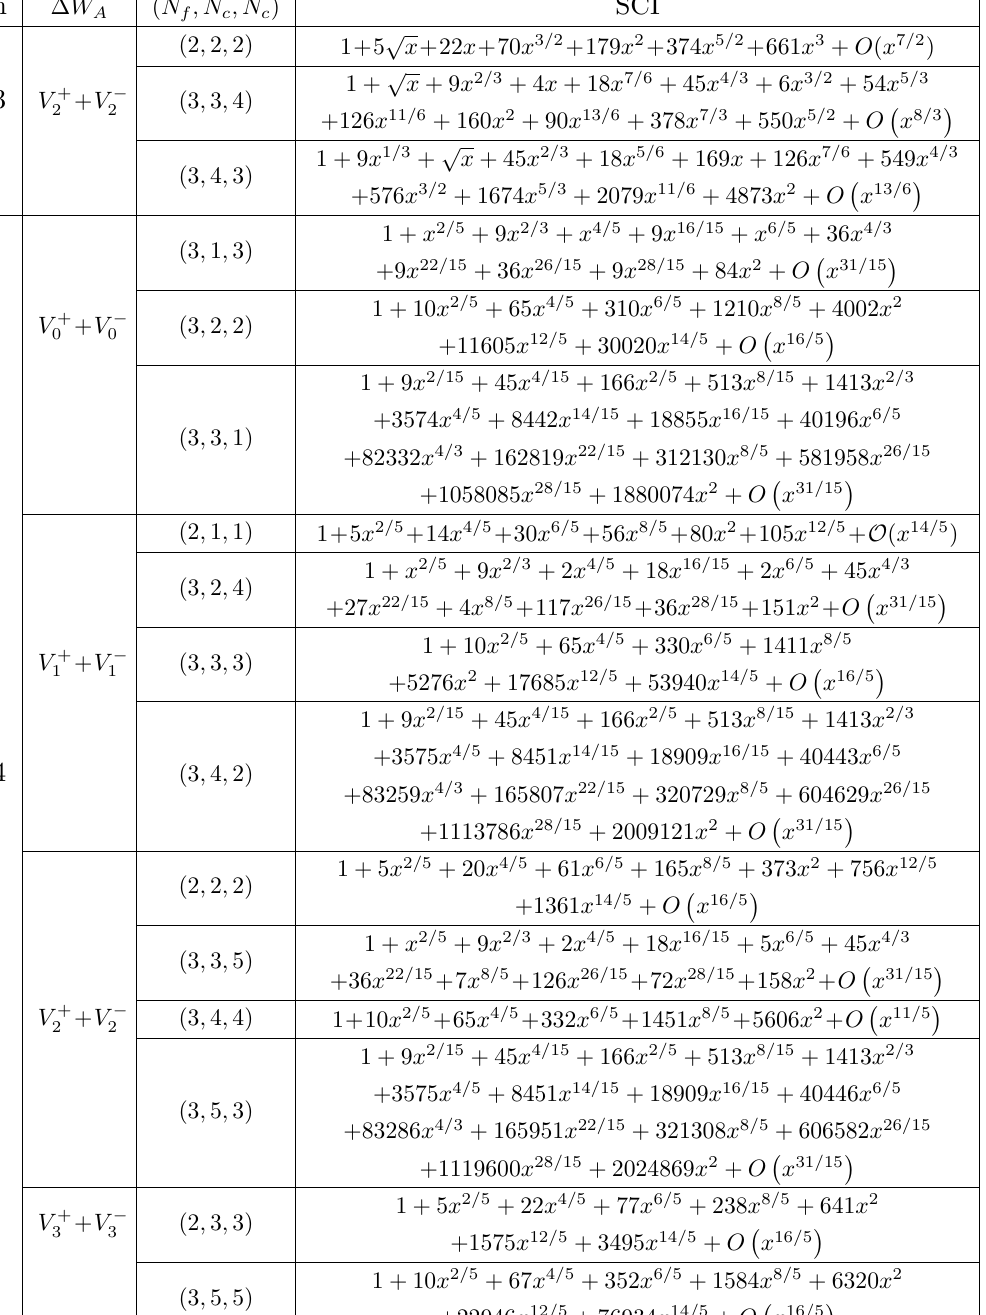
Table 13 . The superconformal index results for the single adjoint theories with ∆ W A = V + For simplicity, the SU( N ) SU( N ) flavor fugacities are all omitted. This table includes all f t × f u ˜ possible cases up to n ≤ 4 , N 3 , and N N c ≤ 5 with conditions ∆ Q , ∆ q > 0 . Especially, we f ≤ c , exhibit more results with N 5 for n = 1 , in which case the adjoint field becomes massive such that f ≤ the corresponding duality is nothing but the Benini-Benvenuti-Pasquetti duality [21]. In addition, the case with ∆ W = V + + V − corresponds to the Amariti-Cassia duality [46]. Therefore, our A 0 0 index results provide nontrivial evidence for those